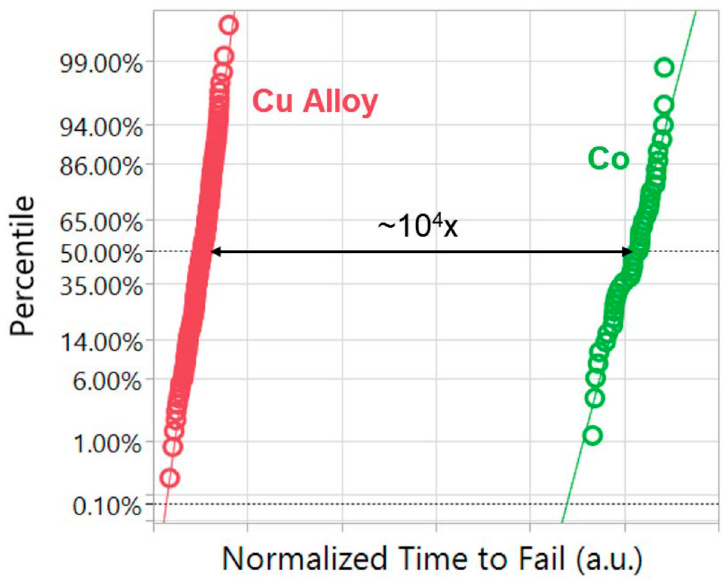
Figure 24. EM lifetime distributions for the Co and Cu alloy [157].